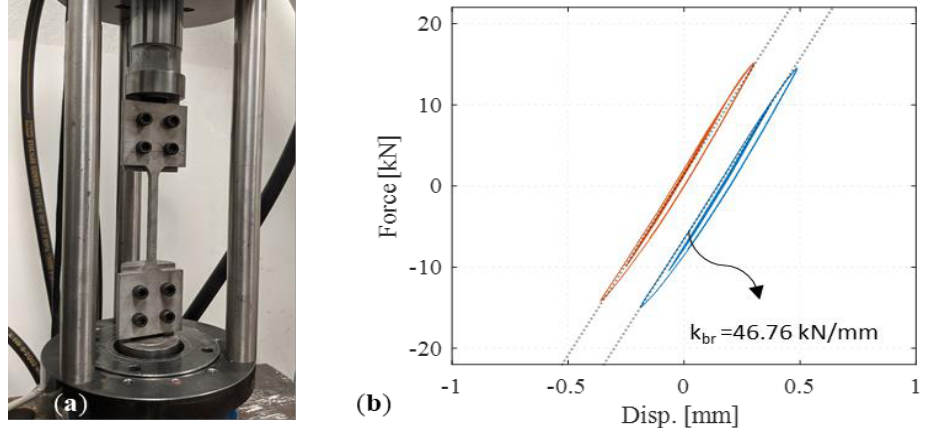
Figure 5. ( a ) Actual brace specimen in the load frame, ( b ) brace hysteresis from two different cyclic test results in linear range.